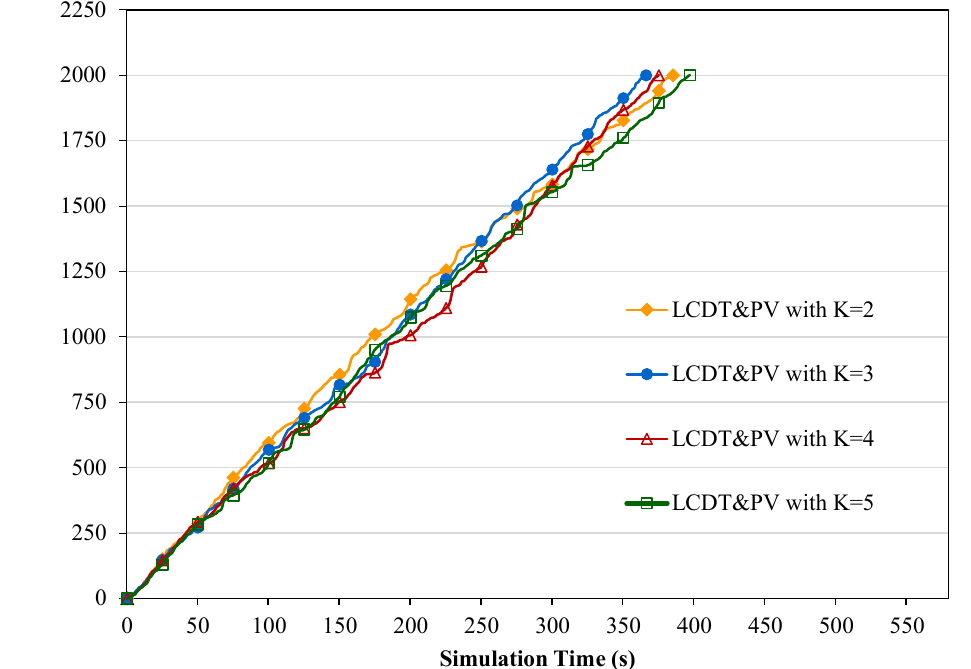
Figure 5. Comparison of the effectiveness with varied K in the LCDT&PV